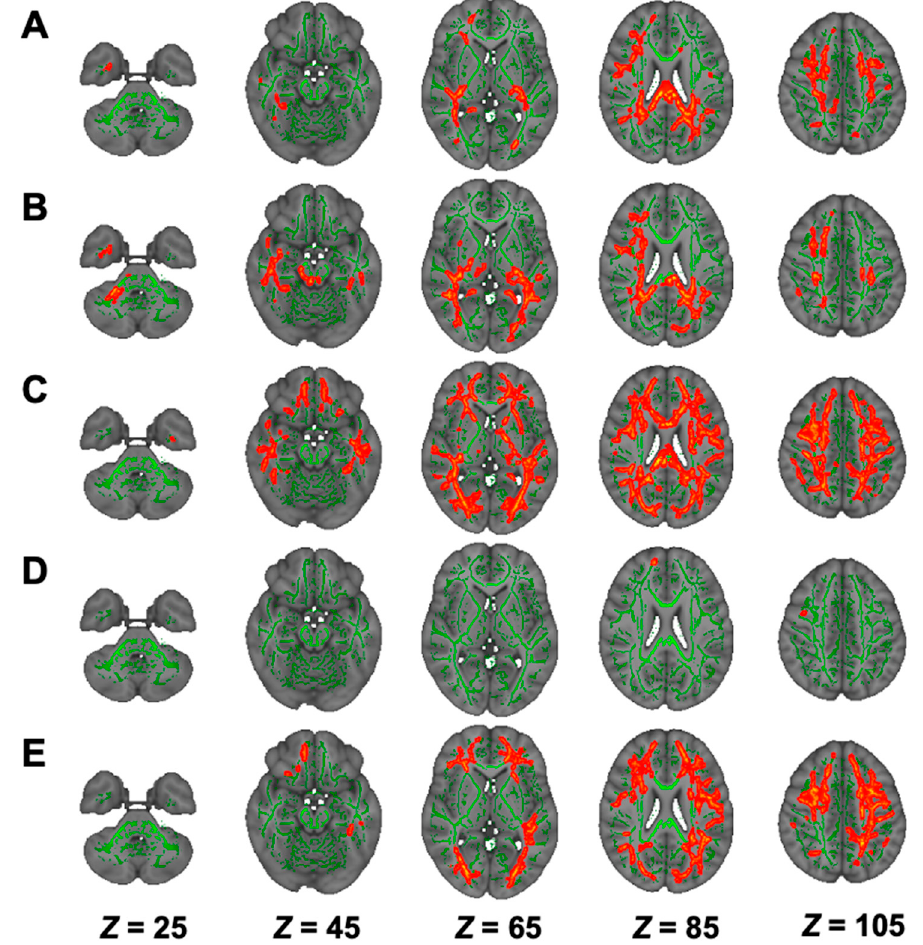
Figure 4. Comparison of TBSS of DKI among hemodialysis patients with NSTLC and LTLC and healthy controls. Comparisons of DKI (AK, ( A , B ); RK, ( C , D ); and MK, ( E ) indices among hemodialysis patients with NSTLC and LTLC and healthy controls are shown. TBSS analyses show that hemodialysis patients treated with NSTLC have significantly lower AK, RK, and MK than healthy controls ( p < 0.05, ( A , C , E )). Significant but limited low fiber tracts in AK and RK in hemodialysis patients treated with LTLC compared to healthy controls are found ( p < 0.05, ( B , D )). The skeleton is presented in green. To aid visualization, the results are thickened using the fill script implemented in the FMRIB Software Library. AK, axial kurtosis; DKI, diffusion kurtosis imaging; LTLC, long-term L -carnitine treatment; MK, mean kurtosis; NSTLC, no or short-term L -carnitine treatment; RK, radial kurtosis; TBSS, tract-based spatial statistics.